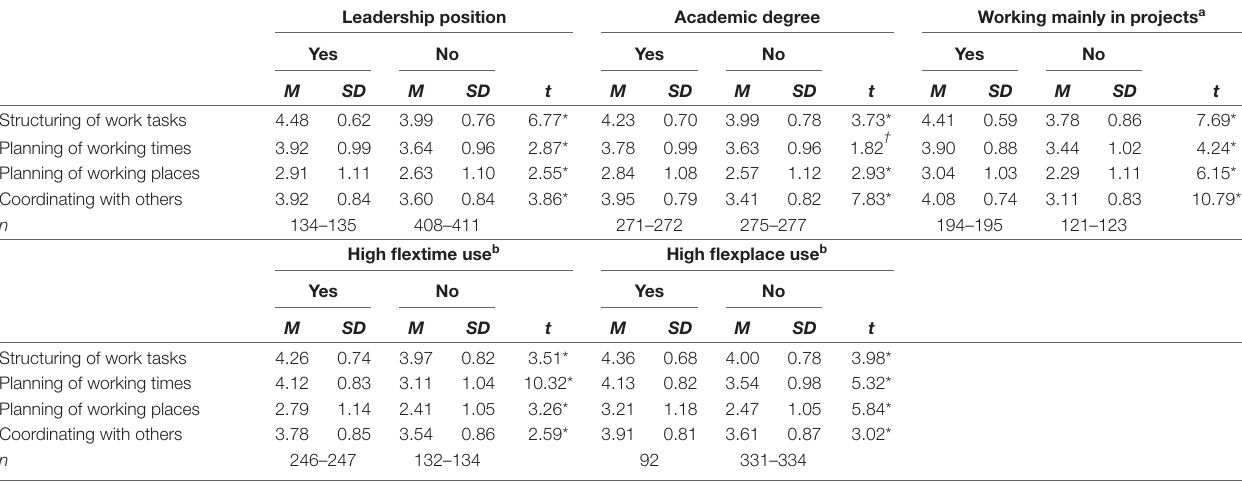
TABLE 7 | Comparison of means between different groups in study 3. Leadership position Academic